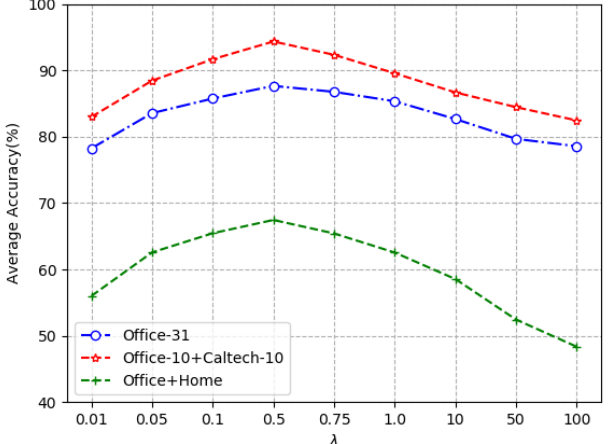
Figure 4. Converge curves of MultiDTNN on three datasets.